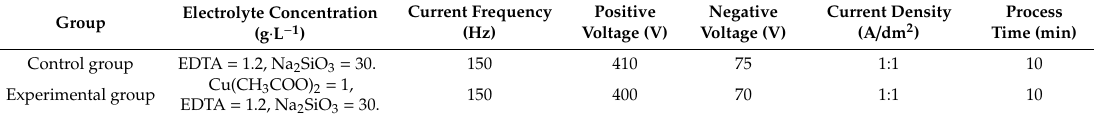
Table 1. Experimental parameters and electrolyte concentration during microarc oxidation (MAO).